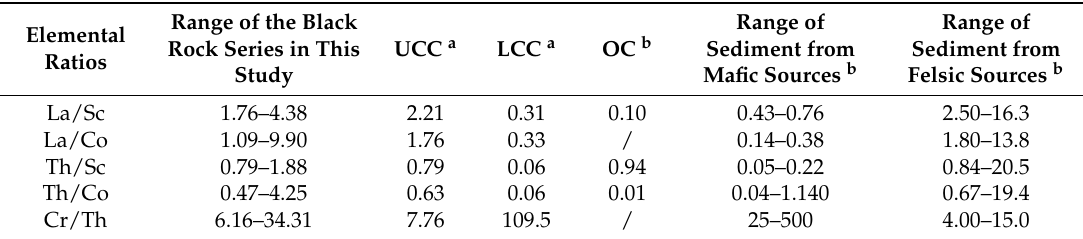
Table 6. Range of several elemental ratios from the black rock series in this study compared with the counterparts in sediments originated from the UCC, LCC, OC, mafic rocks, and felsic